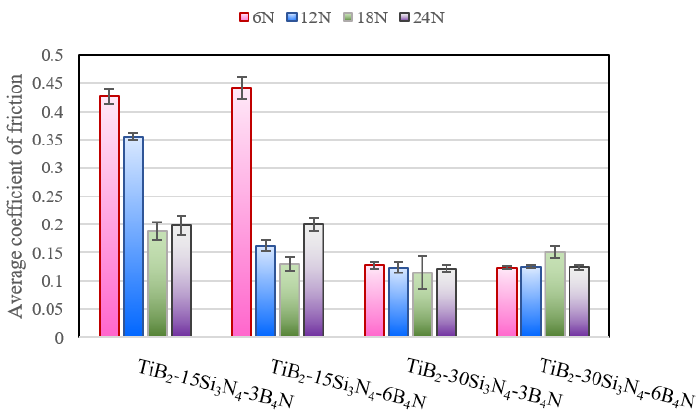
Figure 14. Average coefficient of friction of sintered composites.